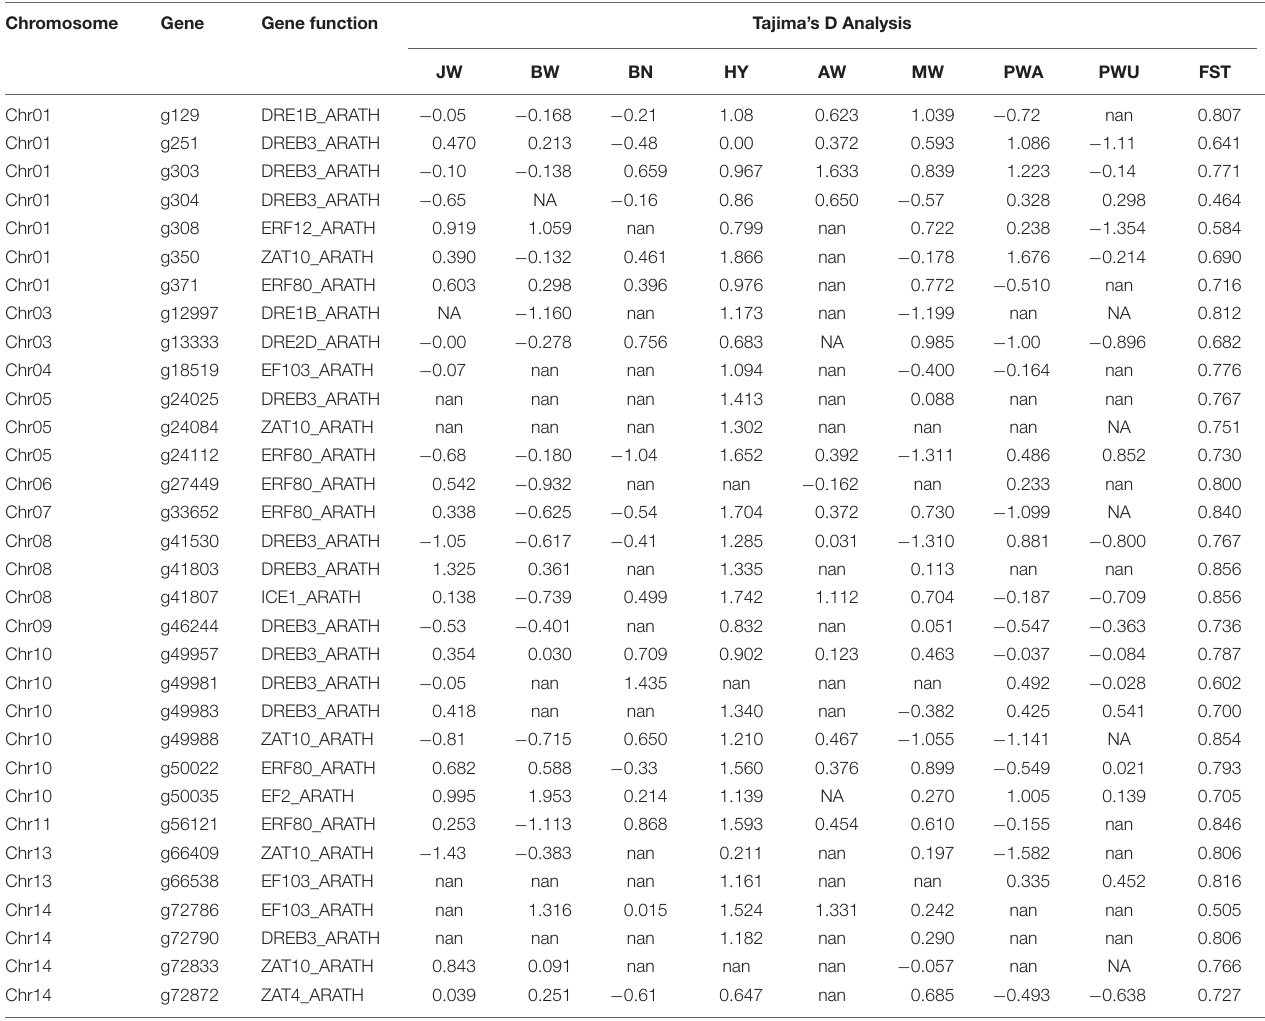
TABLE 3 | Statistical data of population indices for cold hardy genes among the nine identified Juglans pools. Chromosome Gene Gene